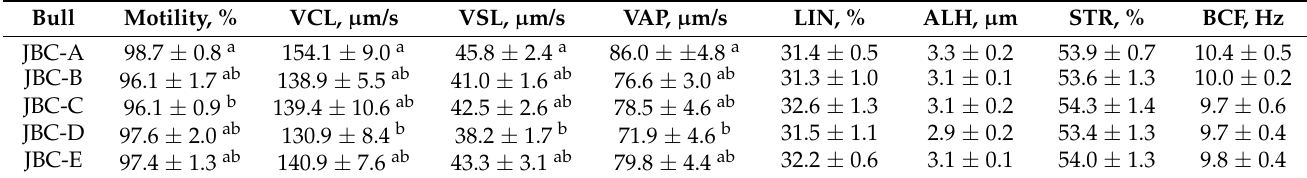
Table 1. Motility parameters of fresh sperm from individual JBC bulls, as evaluated by SAIS.